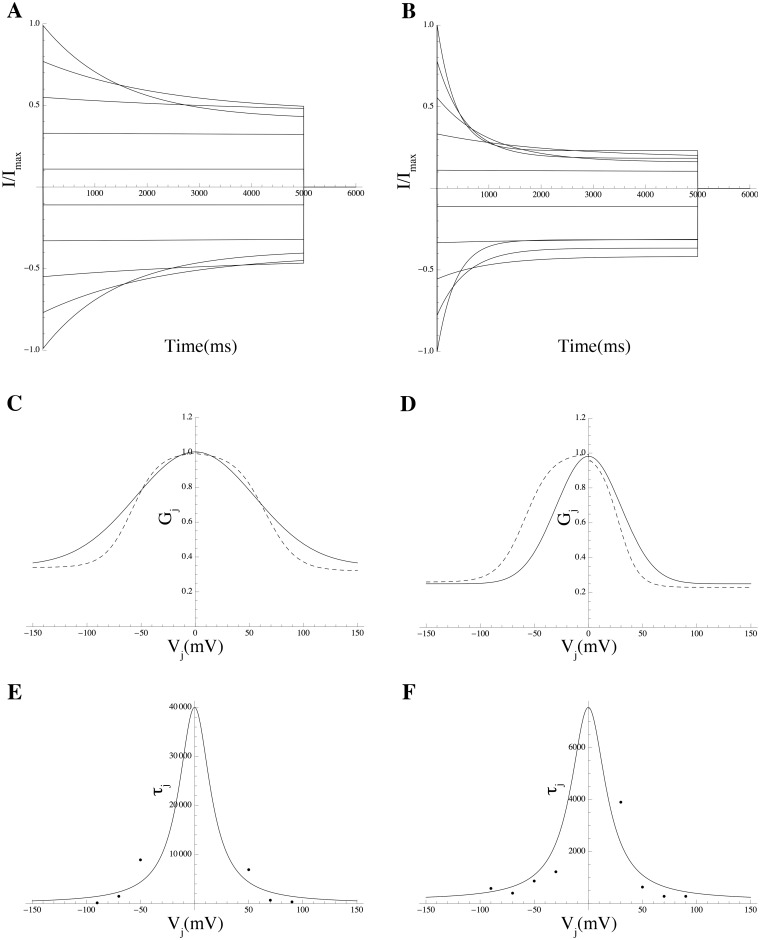
Properties of the gap junctions in MSMC.Simulated currents for Type I and Type II are shown in (A) and (B), respectively. The currents are elicited in response to 5 s square pulses in the voltage range of ± 90 mV from holding potential of 0 mV. Steady-state conductance as function of Vj for Type I an Type II shown in (C) and (D), respectively, using quasi-symmetrical Boltzmann functions (dashed line) and the Gaussian function (solid line). The time constant as function of Vj for Type I and Type II are shown in (E) and (F), respectively.